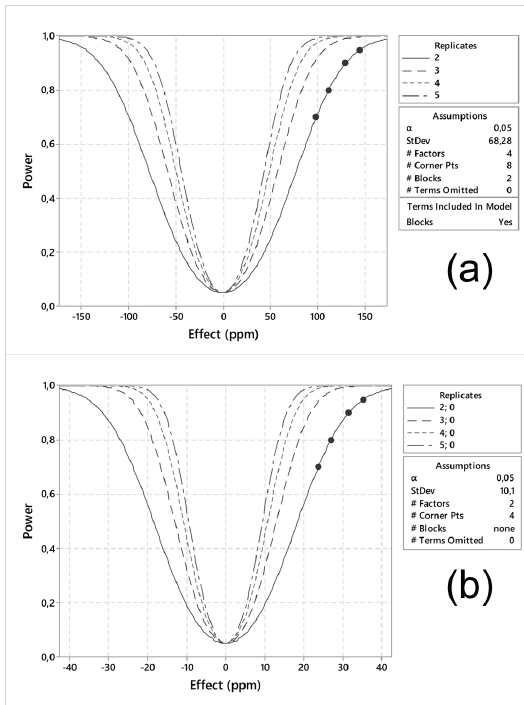
Cu Al Nb 48 46.5 4 1.5